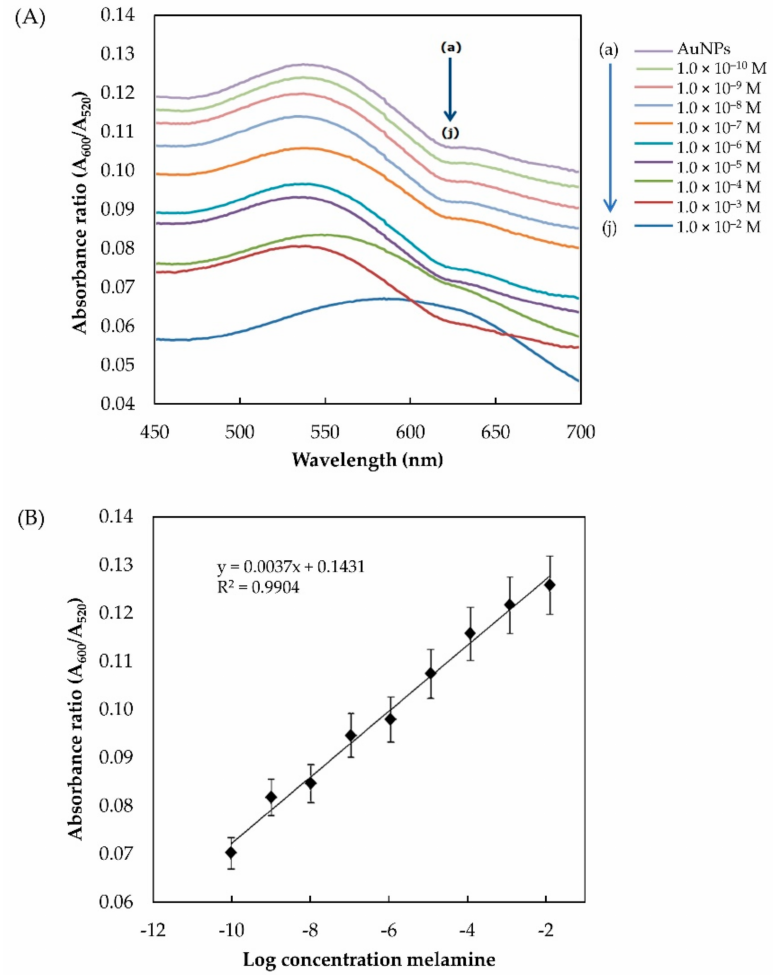
Figure 8. ( A ) Absorption spectra of the AuNPs generated in the presence of different concentrations of melamine (a–j: control, 1 × 10 − 10 , 1 × 10 − 9 , 1 × 10 − 8 , 1 × 10 − 7 , 1 × 10 − 6 , 1 × 10 − 5 , 1 × 10 − 4 , 1 × 10 − 3 , and 1 × 10 − 2 M); ( B ) plot of A 600 /A 520 against the log of melamine concentrations ( n =